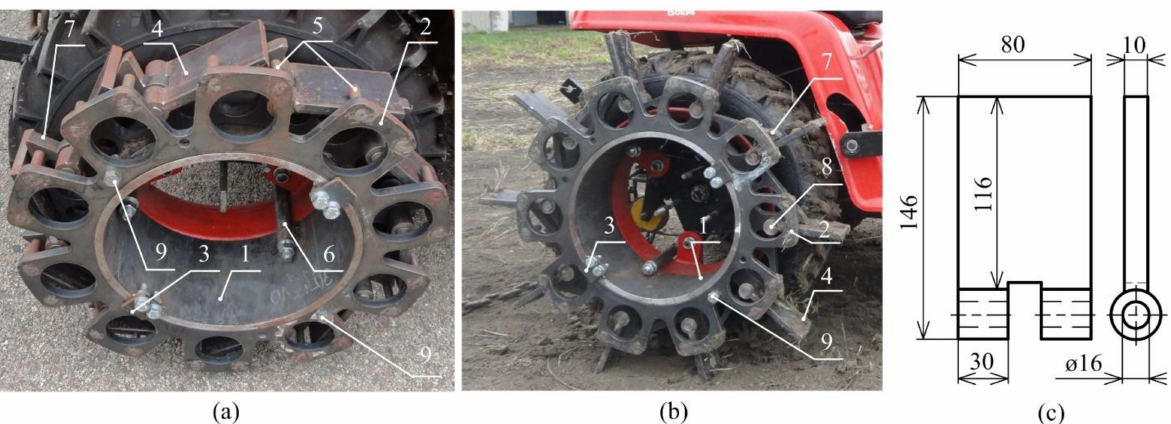
Figure 3. Blade wheels: ( a ) base position for road transportation; ( b ) protruded position for field conditions; ( c ) blade shape and dimensions: 1—support tube, 2—control disc, 3—stop bars, 4—blade, 5—pins, 6—fastening screw, 7—steel triangle, 8—pivot, 9—safety